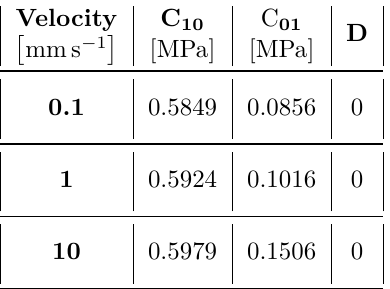
Table 2. Parameter table of the received Mooney- Rivlin model-parameters.